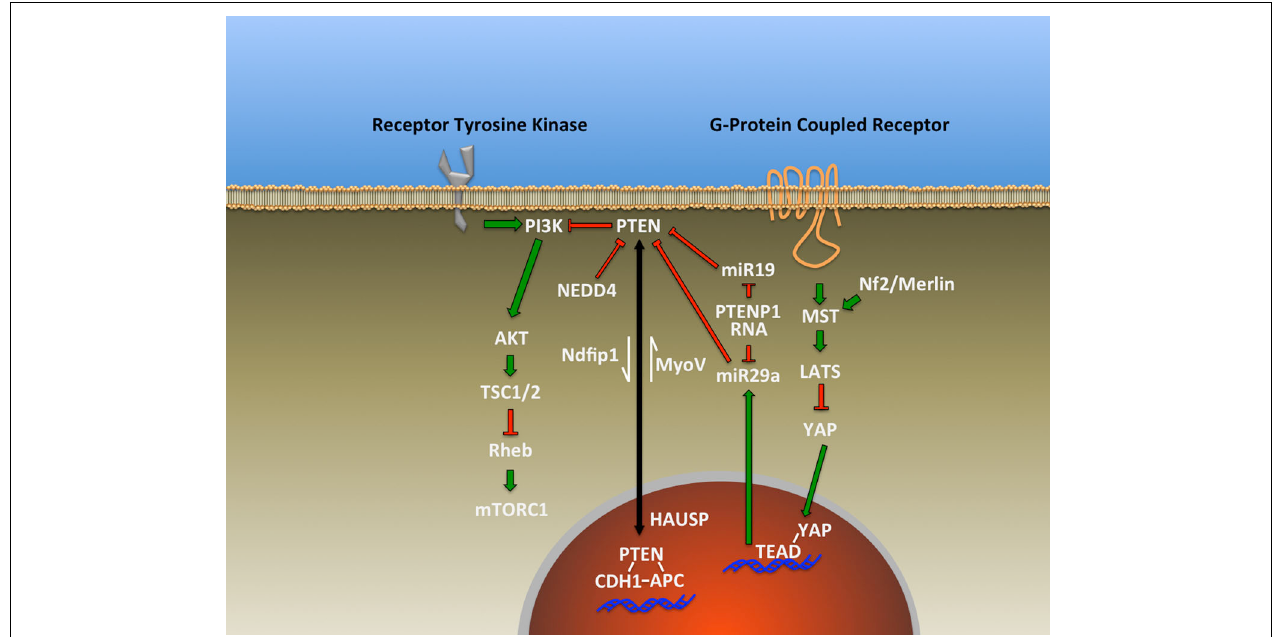
FIGURE 1 | Representative signal transduction pathways that have been found to either influencing or impacted by PTEN as described in the text.